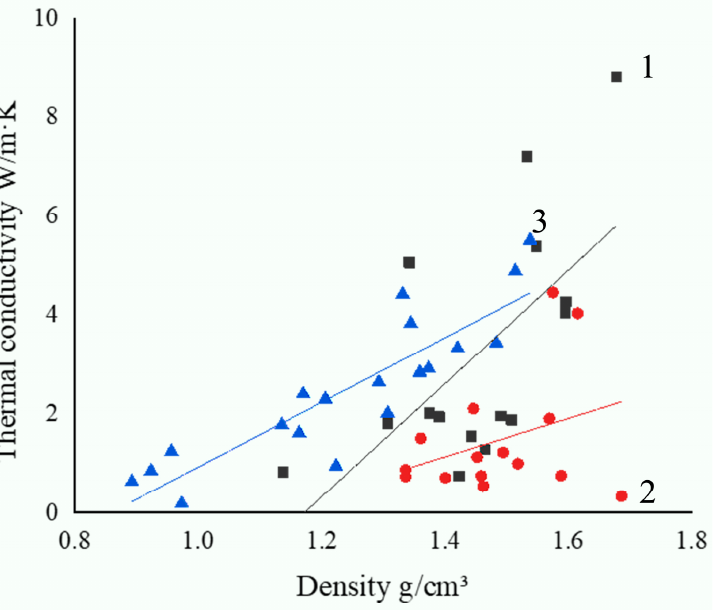
Figure 10. Thermal conductivity asa function of density of PSU-based composite filled with NG (1); AG (2) and EG (3) at 25 °C.